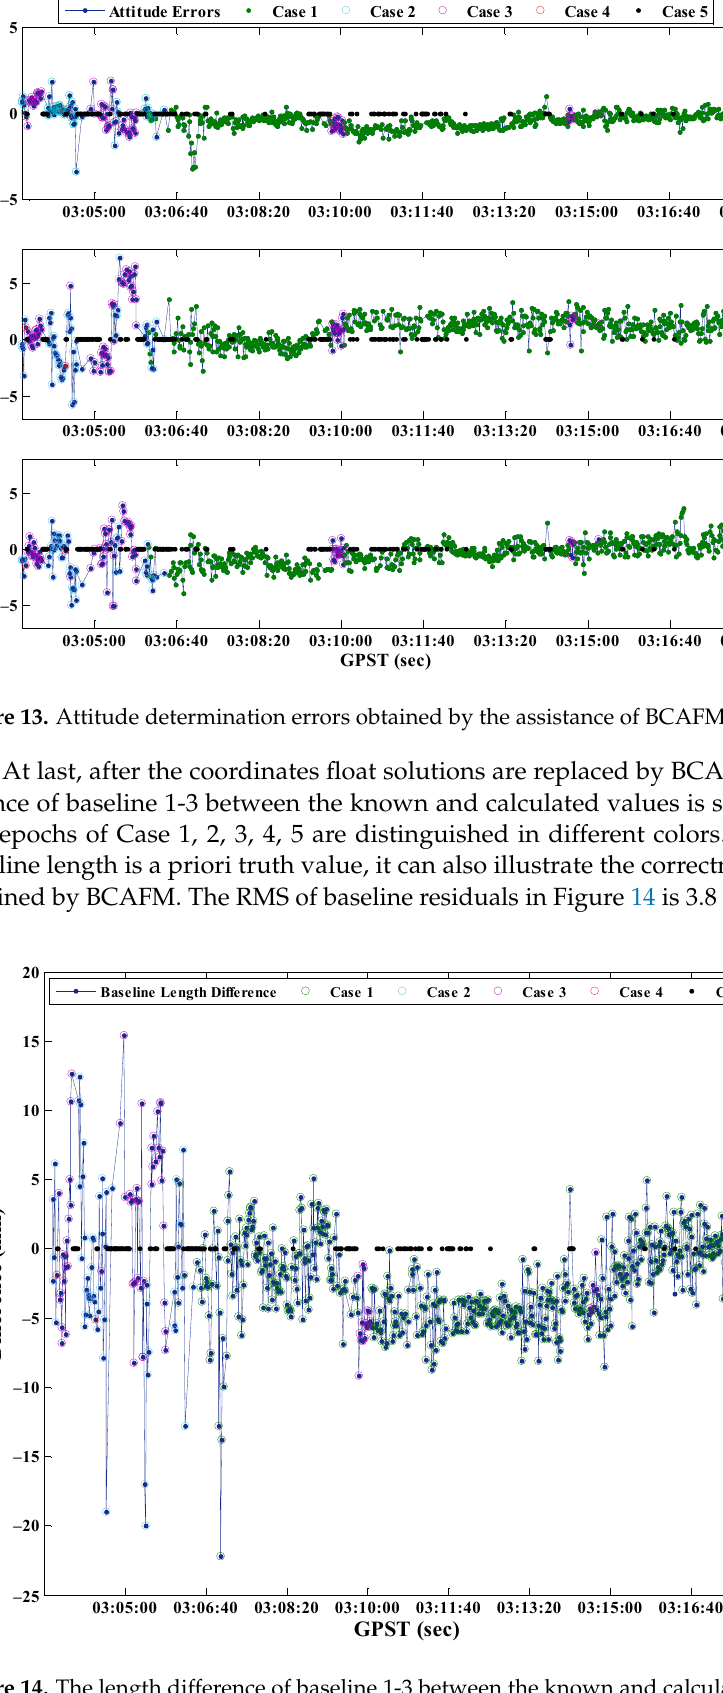
Figure 14. The length difference of baseline 1-3 between the known and calculated values.